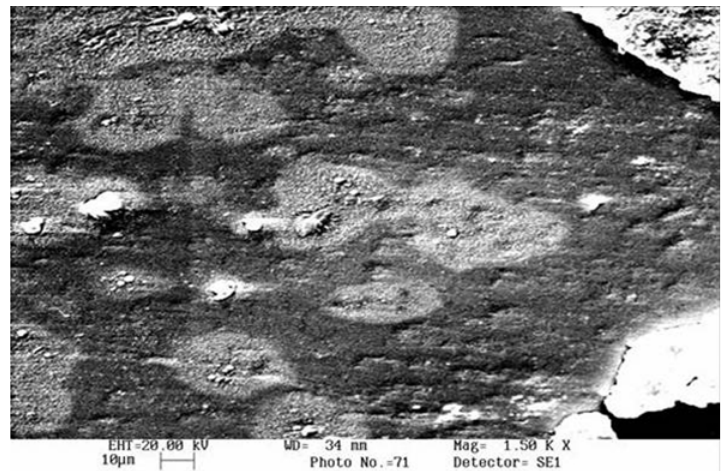
FIGURE 4- SEM micrograph of enamel exposed to a bleaching agent containing 7.5% hydrogen peroxide (Day White 2Z), presenting erosions (×1,500)